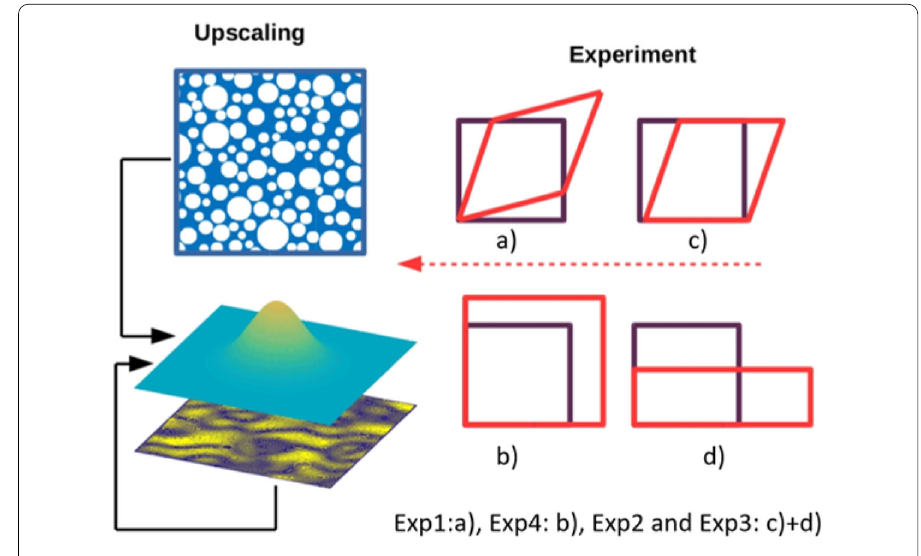
Fig. 2 Experimental